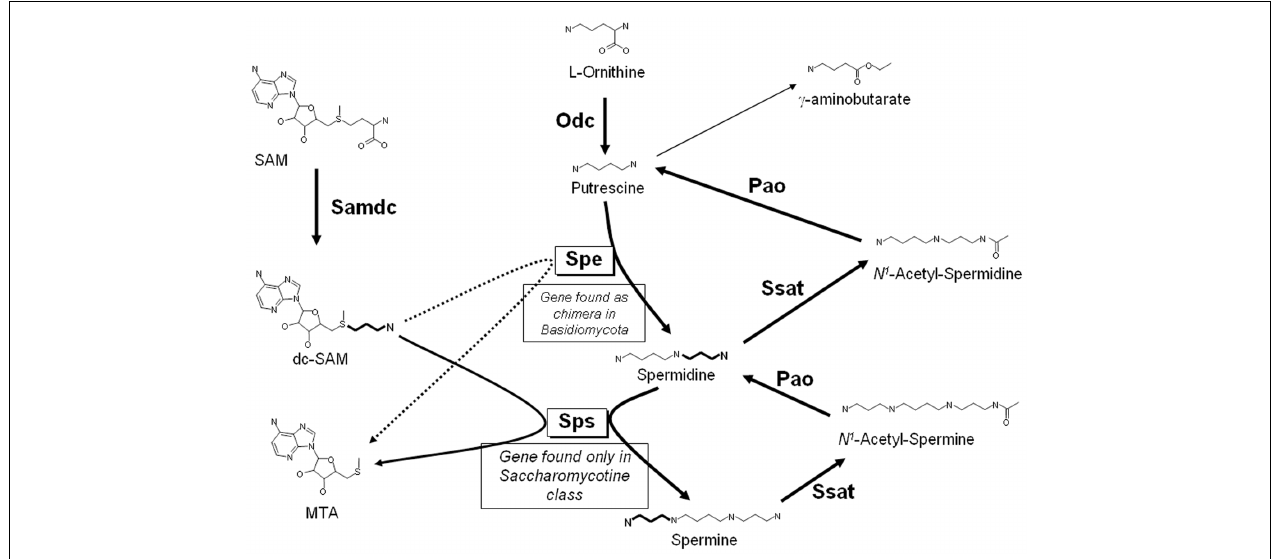
FIGURE 1 | General pathway for the biosynthesis and catabolism of polyamines in fungi.